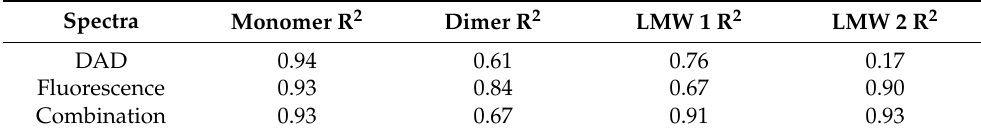
Table 1. Coefficient of determination (R 2 ) for different product contents and PLS models.